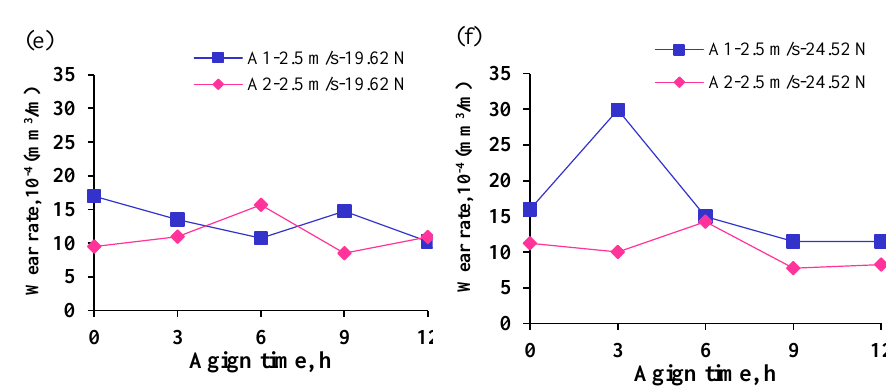
Fig. 8. (a), (b), (c), (d), (e), and (f) are a comparison of base alloy (Al-Si-Mg – A1) and Composites (Al-Si-Mg/TiB 2 – A2) wear rate as a function of aging time by varying sliding speed (2, 2.5 m/s) and normal applied load (14.71, 19.62, 24.52